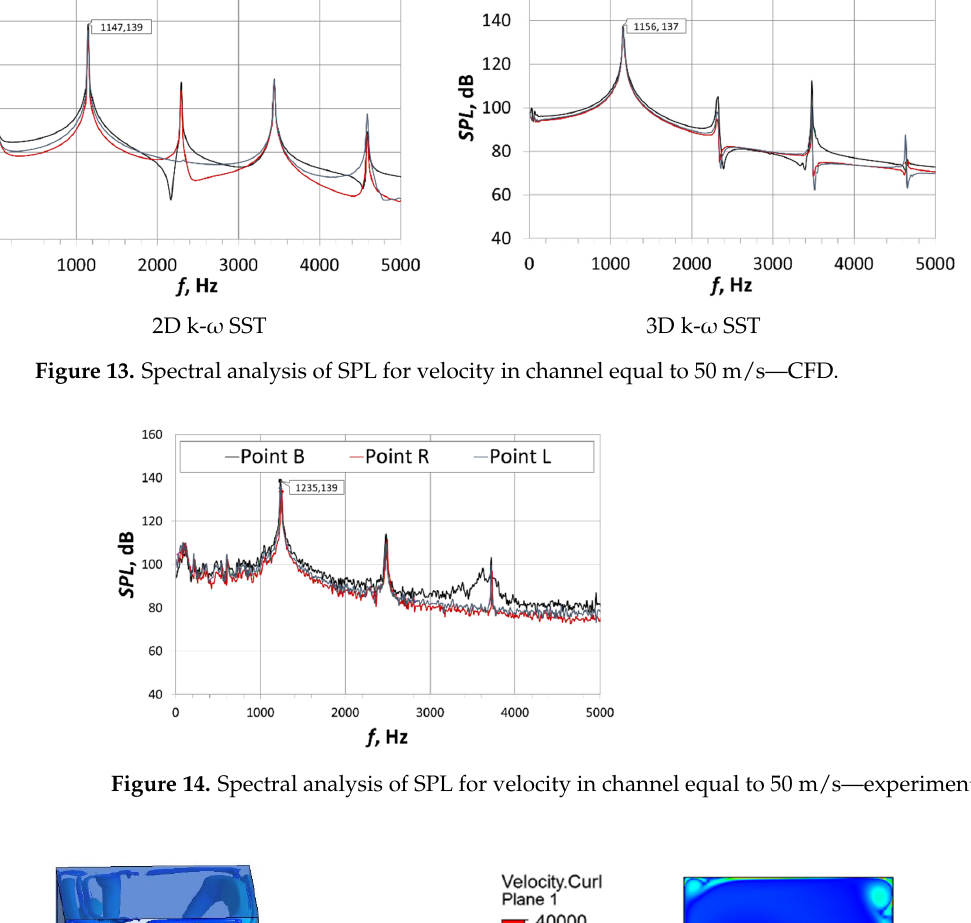
Figure 14. Spectral analysis of SPL for velocity in channel equal to 50 m/s—experimental data.